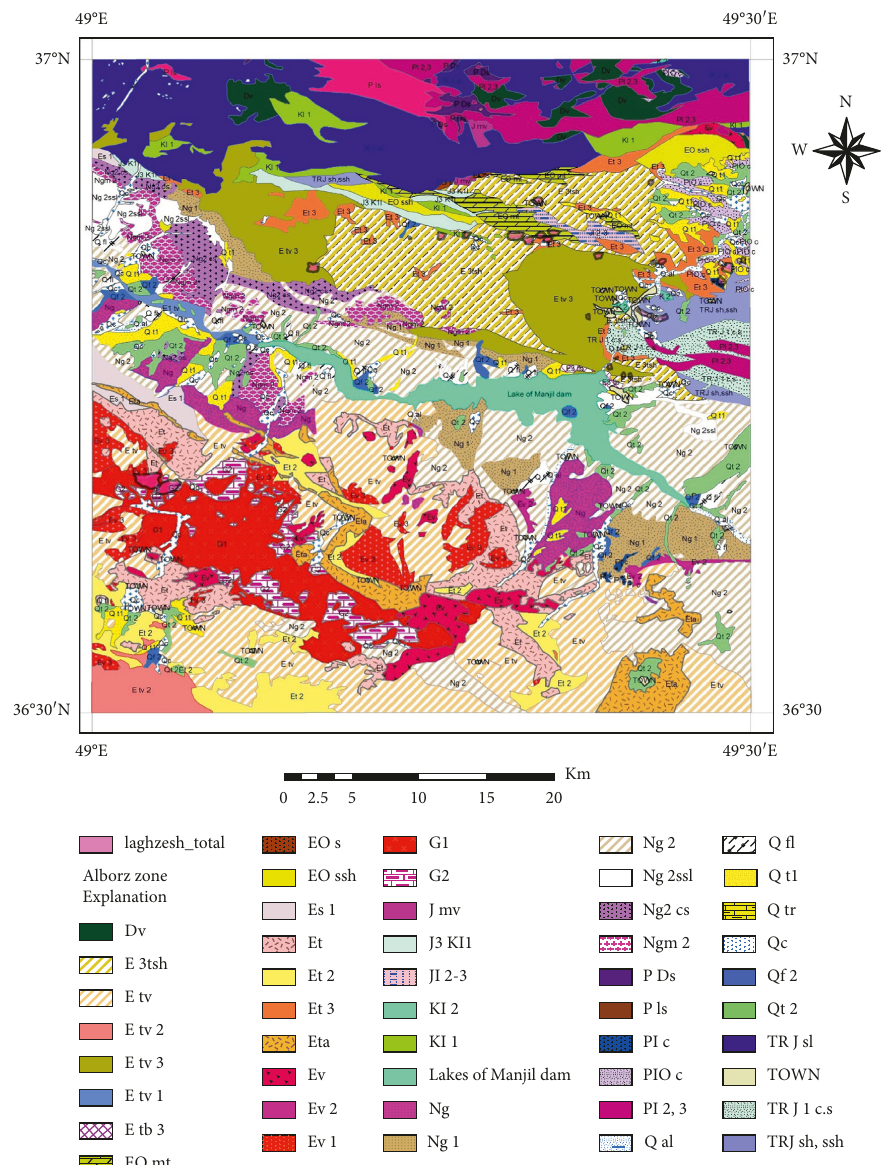
Figure 10: The geologic map of Roudbar quadrangle